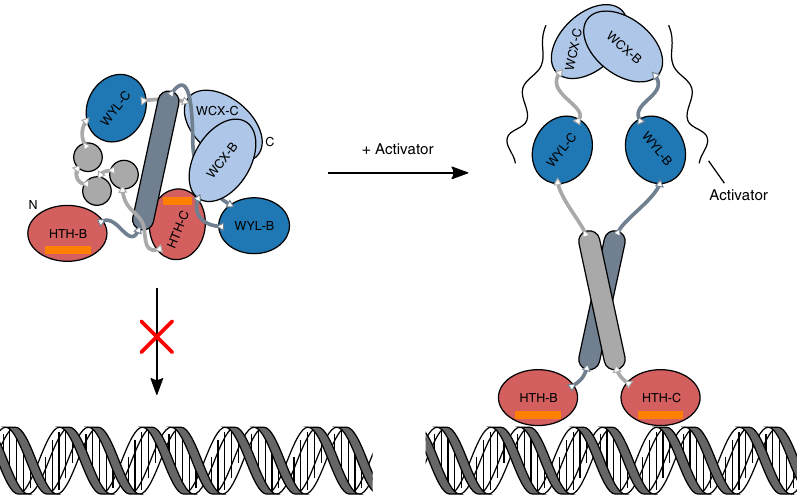
Fig. 7 Hypothetical model of DNA binding by activated PafBC. In the non-activated state, PafBC buries the recognition helix (orange) of PafC ’ s HTH domain (HTH-C) and cannot bind to its cognate promoter motif. Upon activator binding, PafBC likely undergoes large structural rearrangements of its domains to release the HTH-C domain, allowing promoter recognition and transcriptional activation of DNA repair